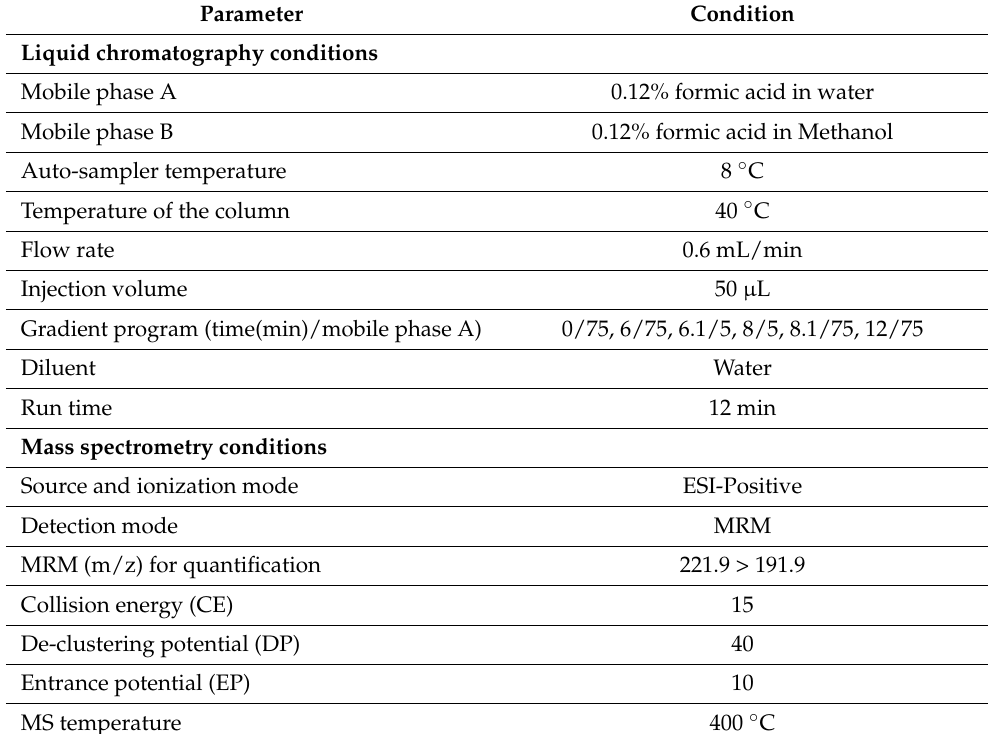
Table 1. Liquid chromatographic and mass spectrometric method conditions. Parameter